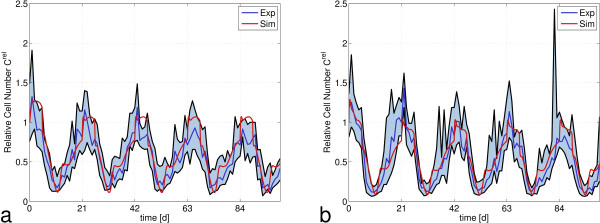
Comparison of the predictions of the hybrid model with clinical data on leukocyte dynamics in peripheral blood during chemotherapy without G-CSF. Clinical data of a) CHOP-21 and b) CHOEP-21 administration (Blue: median of patients, black: 25 and 75 percentiles) are compared with corresponding simulation results of the hybrid model (red). Simulation results fit well to clinical data in the sense that they lie in the interquartile range of data for almost all time points. Cell numbers are normalized with respect to the average WBC/leukocyte count value of healthy individuals (7000 cells/μl).